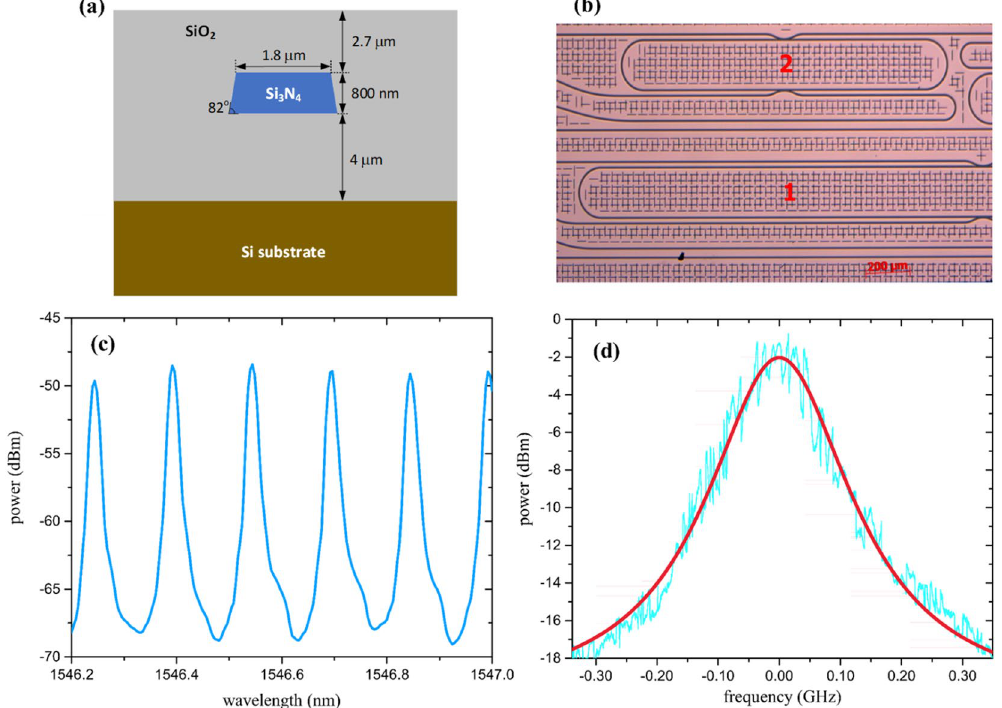
Figure 2. Characteristics of the ring resonator. ( a ) Cross-section of the waveguide. ( b ) Top layout of a portion of the chip. For the experiment, ring 1 with a free spectral range of 18.774 GHz has been used. Due to lack of space, only half of the ring 1 is shown. However, the layout is the same as that of ring 2. ( c ) Transfer characteristic at the drop port measured using a broadband source and an optical spectrum analyser with 0.02 nm resolution. ( d ) Single resonance peak at 1545.94 nm, measured by an optical power meter and a frequency scan (cyan) with a Mach-Zehnder modulator driven with a tunable RF frequency. The red curve corresponds to the Lorentzian fit to the measured data. The calculated finesse is 145.